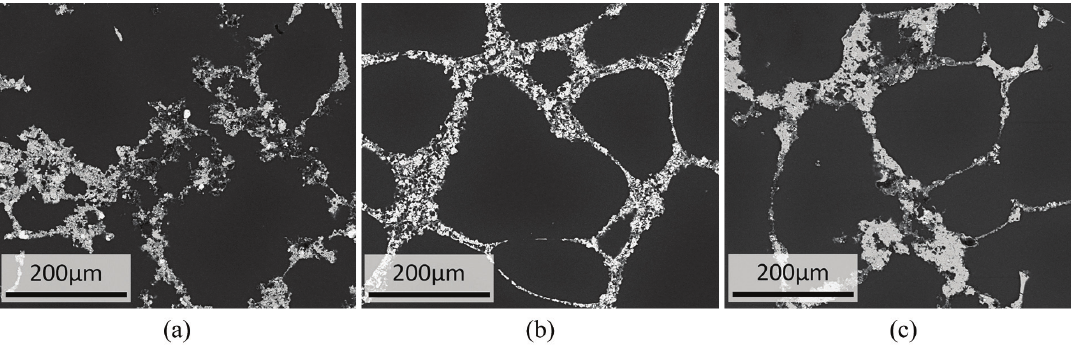
Figure 3. BSE images of the investigated ZK60-RE alloys submitted to solution heat treatment for 16h at 380 °C: (a) ZK60-0.5 wt.%RE, (b) ZK60-1.5 wt.%RE and (c) ZK60-2.5